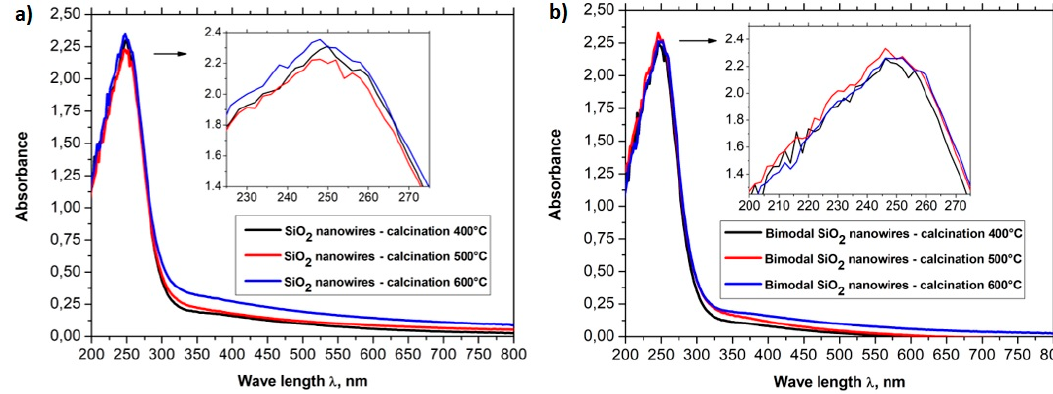
Figure 10. UV-Vis spectra obtained for ( a ) SiO 2 nanowires and ( b ) bimodal SiO 2 nanowires.